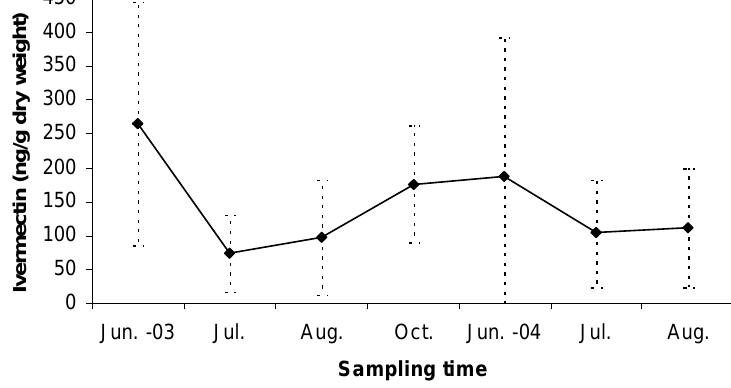
Fig. 1. Gjennomsnitt og standardavvik for ivermektinkonsentrasjoner i prøver fra de forskjellige innsamlings- tidspunkter fra juni 2003, 6 måneder etter utlegging av møkk, og fram til august 2004, bortimot to år et- ter utlegging. Gjennomsnittskonsentrasjonen var høyere enn 74 ng/g ved alle prøvetidspunkter. De store standardavvikene skyldes blant annet stor heterogenitet i prøvematerialet som følge av variasjon i meng- der av jord, vegetasjonskomponenter og møkk.